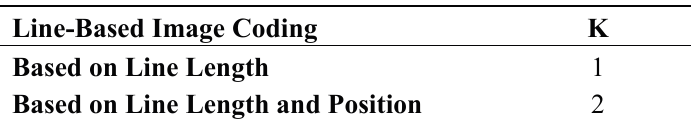
Table 8. Number of parameters per line.